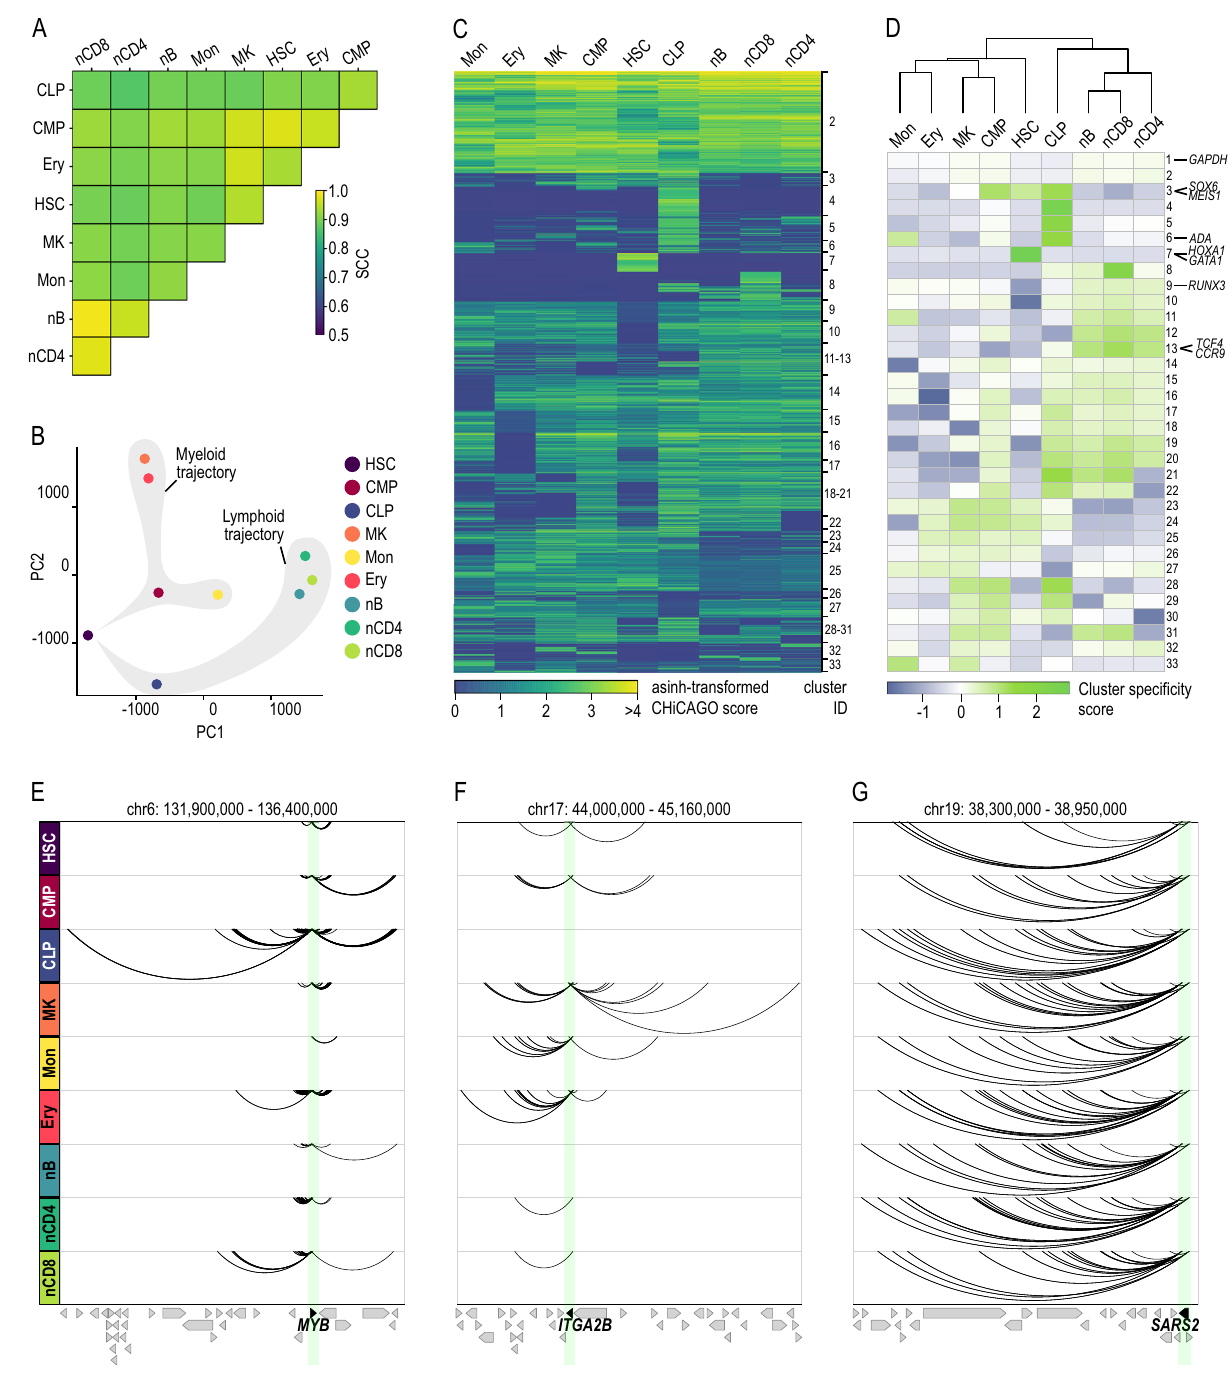
Fig. 2 | liCHi-C enables the study of in vivo human hematopoiesis. A Heatmap displaying stratum-adjusted correlation coef fi cient (SCC) between promoter interactomes of merged biological replicates. HSC hematopoietic stem cell, CMP common myeloid progenitor, CLP common B-cell lymphoid progenitor, MK megakaryocytes, Mon monocytes, Ery erythroblast, nB naive B cell, nCD4 naive CD4 + cells, nCD8 naive CD8 + cells. B Principal component analysis of liCHi-C sig- ni fi cant interactions (CHiCAGO scores >5) from merged biological replicates. Shadedingrayarethepredicteddifferentiationtrajectoriesforbothlymphoidand